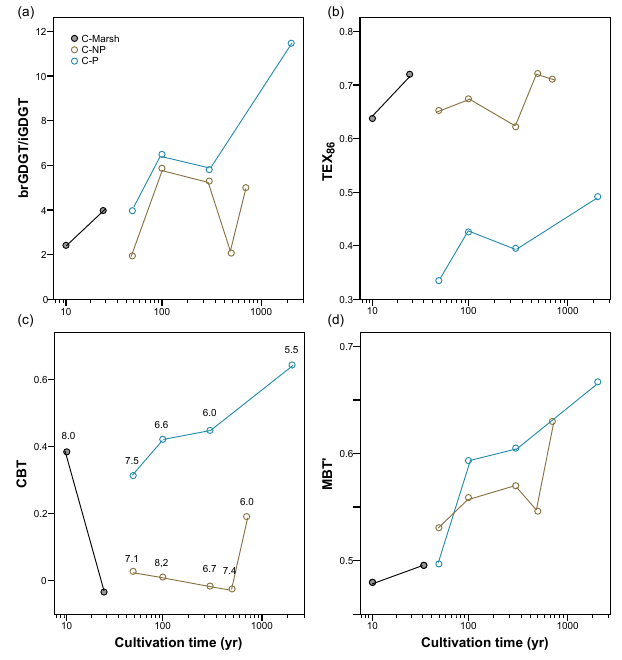
Figure 10. Time plots of various GDGT ratios and indices in soils of the Chinese Cixi region: (a) ratio of branched vs. isoprenoid GDGTs, (b) the TEX 86 , (c) the CBT and (d) MBT (cid:48) . Note logarith- mic scale for the cultivation time. Numbers in plot (c) reflect soil pH values.